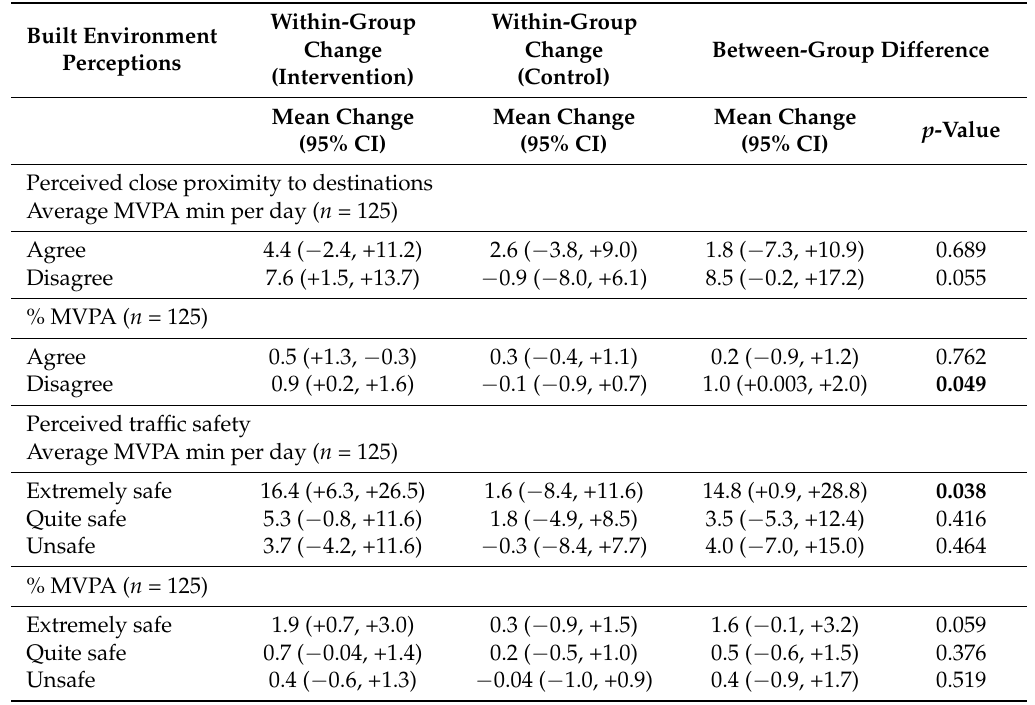
Table 4. Perceived built environment between-group